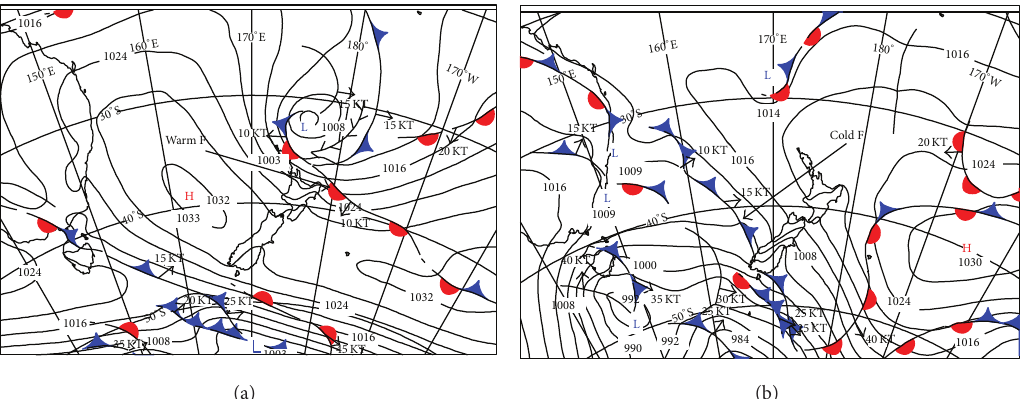
Figure 2: Surface analysis by MetService New Zealand at (a) 0000 NZST 13 October 2010 and (b) 1800 NZST 28 September. “WARM F” in (a) points to the warm front and “COLD F” in (b) points to the cold front. New Zealand lies in the middle of each diagram. Curtesy to MetService New Zealand.